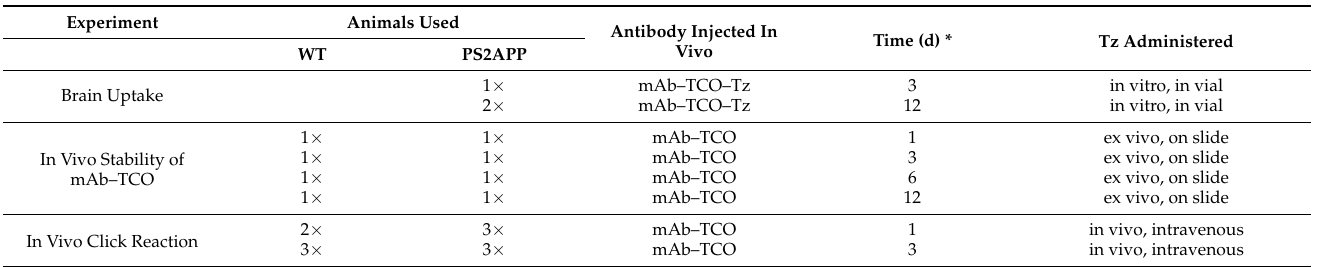
Table 2. Study design and overview of in vivo experiments, used animals, and injected